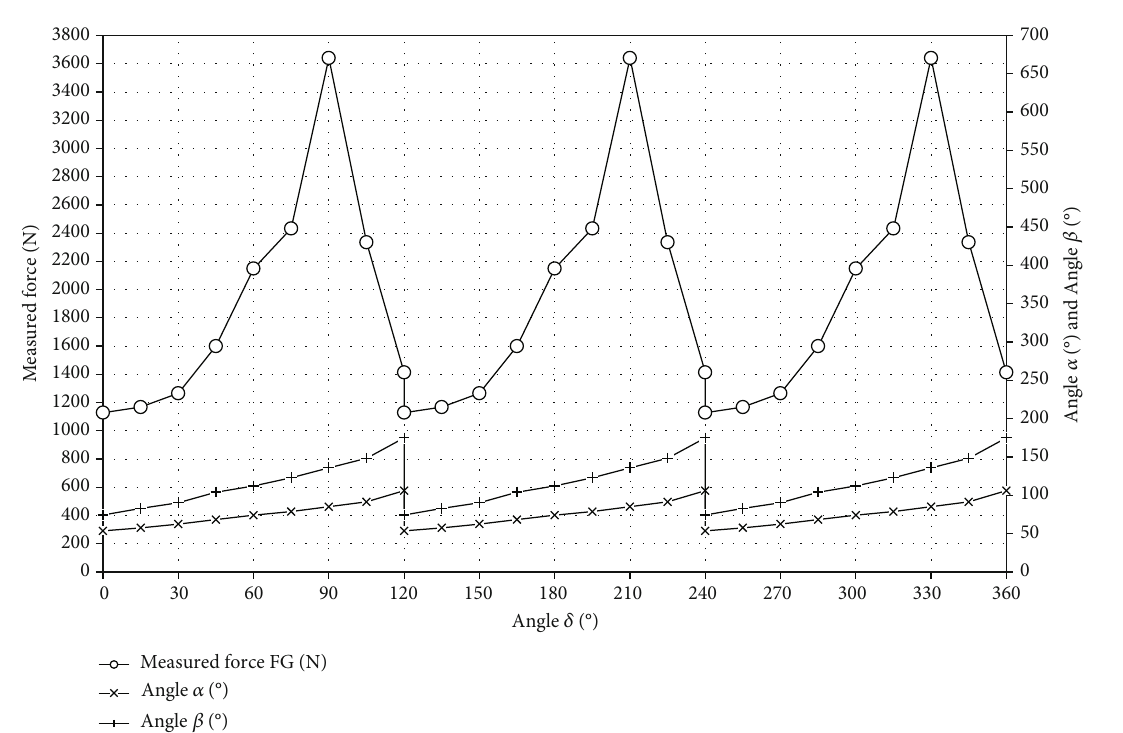
Figure 13: The torque as a function of the angle γ (the crankset drive).